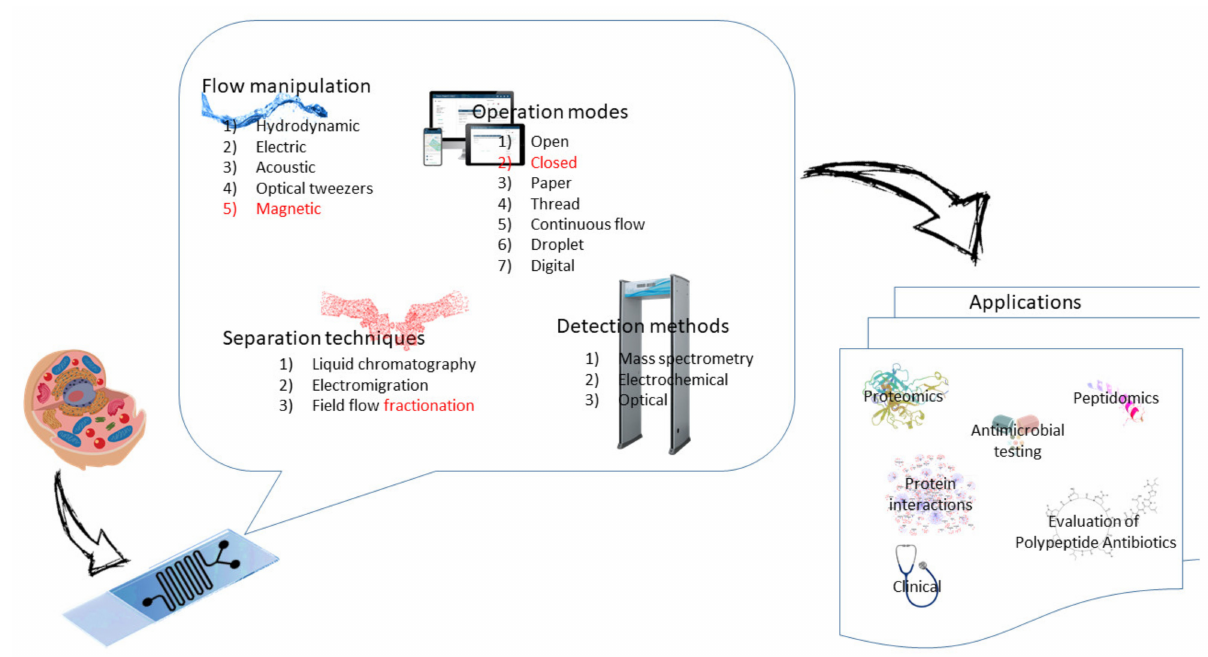
Figure 2. Flow manipulation, operation, separation, detection methods and applications of